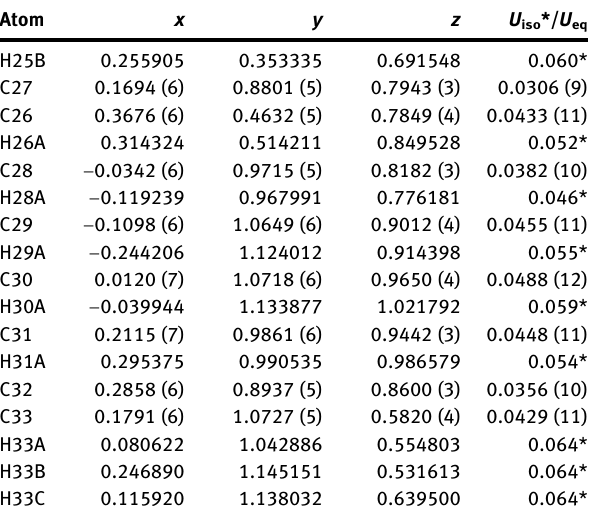
Table  : Fractional atomic coordinates and isotropic or equivalent isotropic displacement parameters (Å 